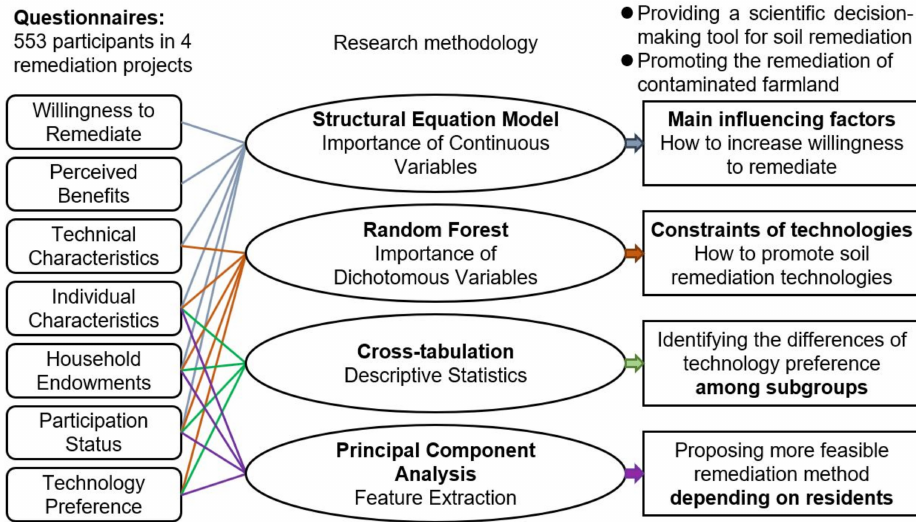
Figure 1. Flow chart of the